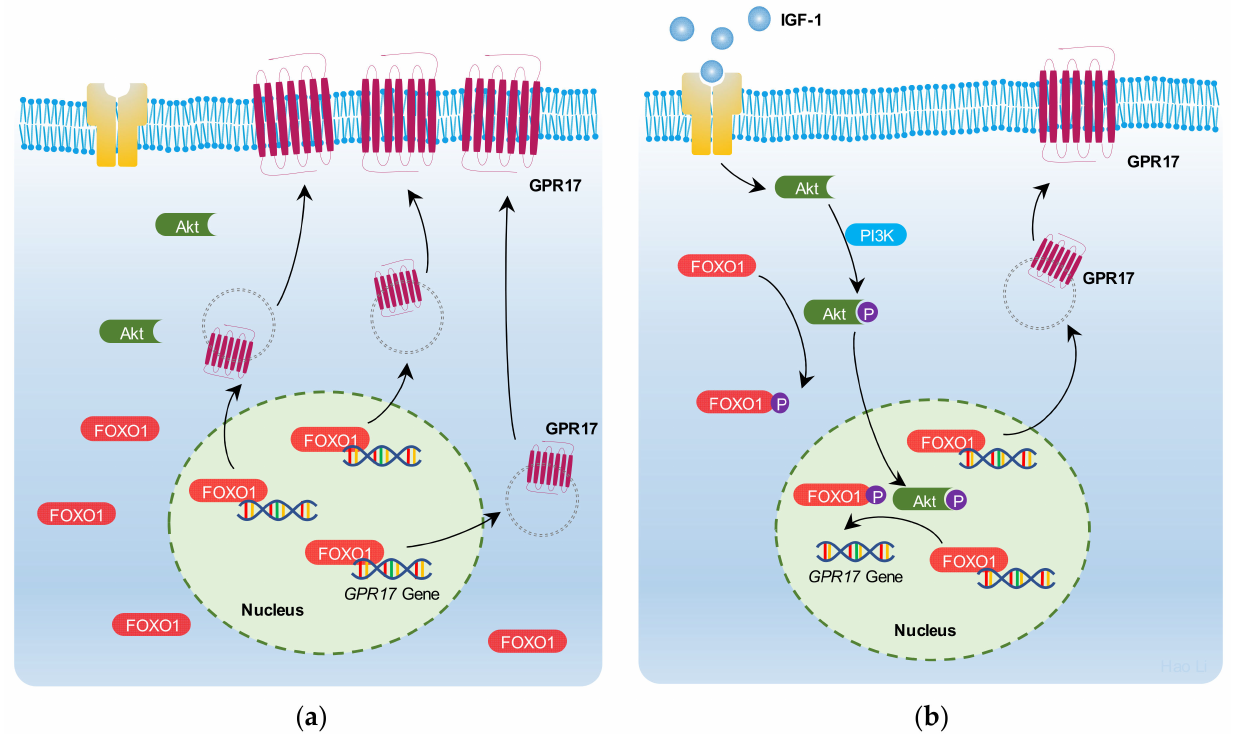
Figure 6. IGF-1/PI3K/Akt/FoxO1/GPR17 signaling. The expression of the GPR17 receptor on the cell membrane of SK-N-SH cells is regulated by IGF-1/PI3K/Akt/FoxO1 signaling. ( a ) In starved SK- N-SH cells, the expression of GPR17 receptor on the cell membrane is increased. This may be because the binding of FOXO1 to the promoter regions of GPR17 enhances GPR17 expression; ( b ) IGF-1 could promote the proliferation of SK-N-SH cells. This may be due to the action of IGF-1 receptor by IGF-1, followed by an increase in Akt phosphorylation (pAkt). pAkt promotes FOXO1 phosphorylation and reduces FOXO1 binding to the promoter regions of GPR17 , thus resulting in the downregulation of GPR17 expression in starved SK-N-SH